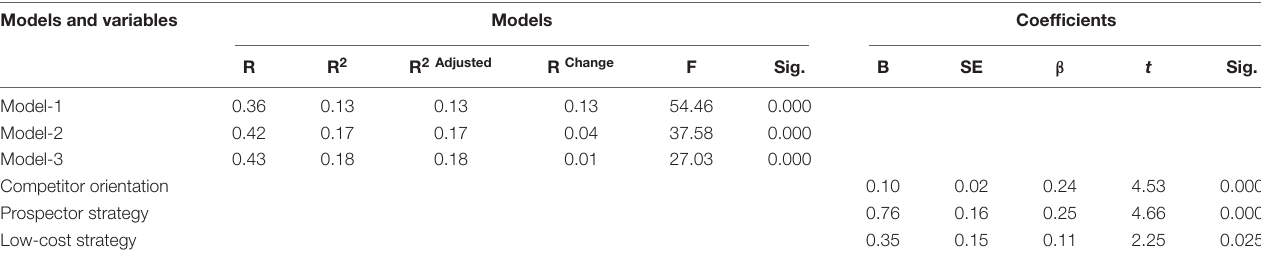
TABLE 4 | Summary of the models, predictive variables, and coefficients of regression analysis (stepwise method): market culture (Spanish subsample n 1 = 362). Models and variables